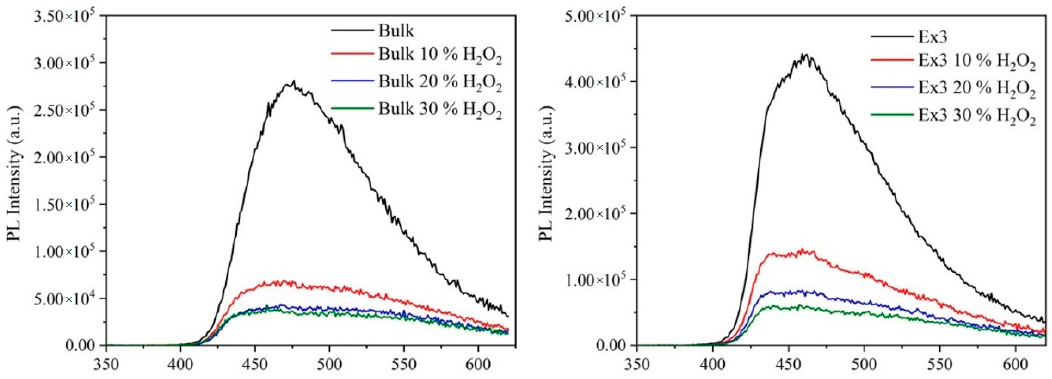
Figure 2. Photoluminescence spectra of bulk ( left ) and exfoliated GCN nanomaterials ( right ).